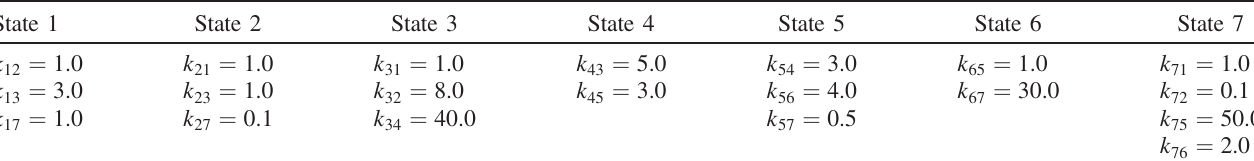
TABLE II. Transition rates for the multicyclic network in Fig. 2.